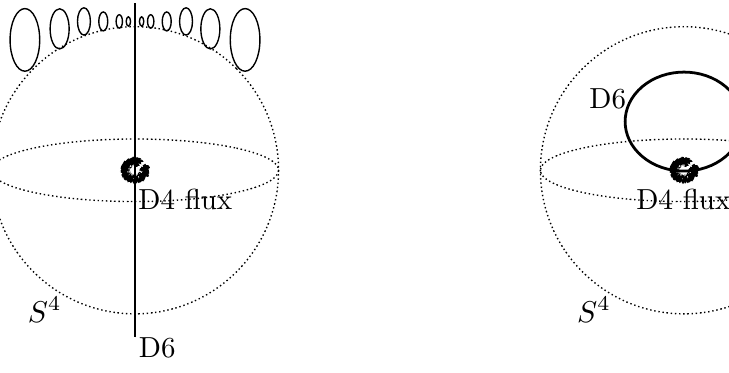
Figure 4 . The left panel depicts a D6-brane with dissolved D4-brane charge, represented as a blurry core. The D4 charge is measured by the flux on a linking S 4 , represented by the dotted sphere. This cycle does not uplift to an S 4 in eleven dimensions because the circle fibration over S 4 has no global section, as it is the double suspension of the Hopf fibration. In the right panel, we now have a spherical D6-brane. The S 4 no longer intersects the D6 worldvolume, so the fibration